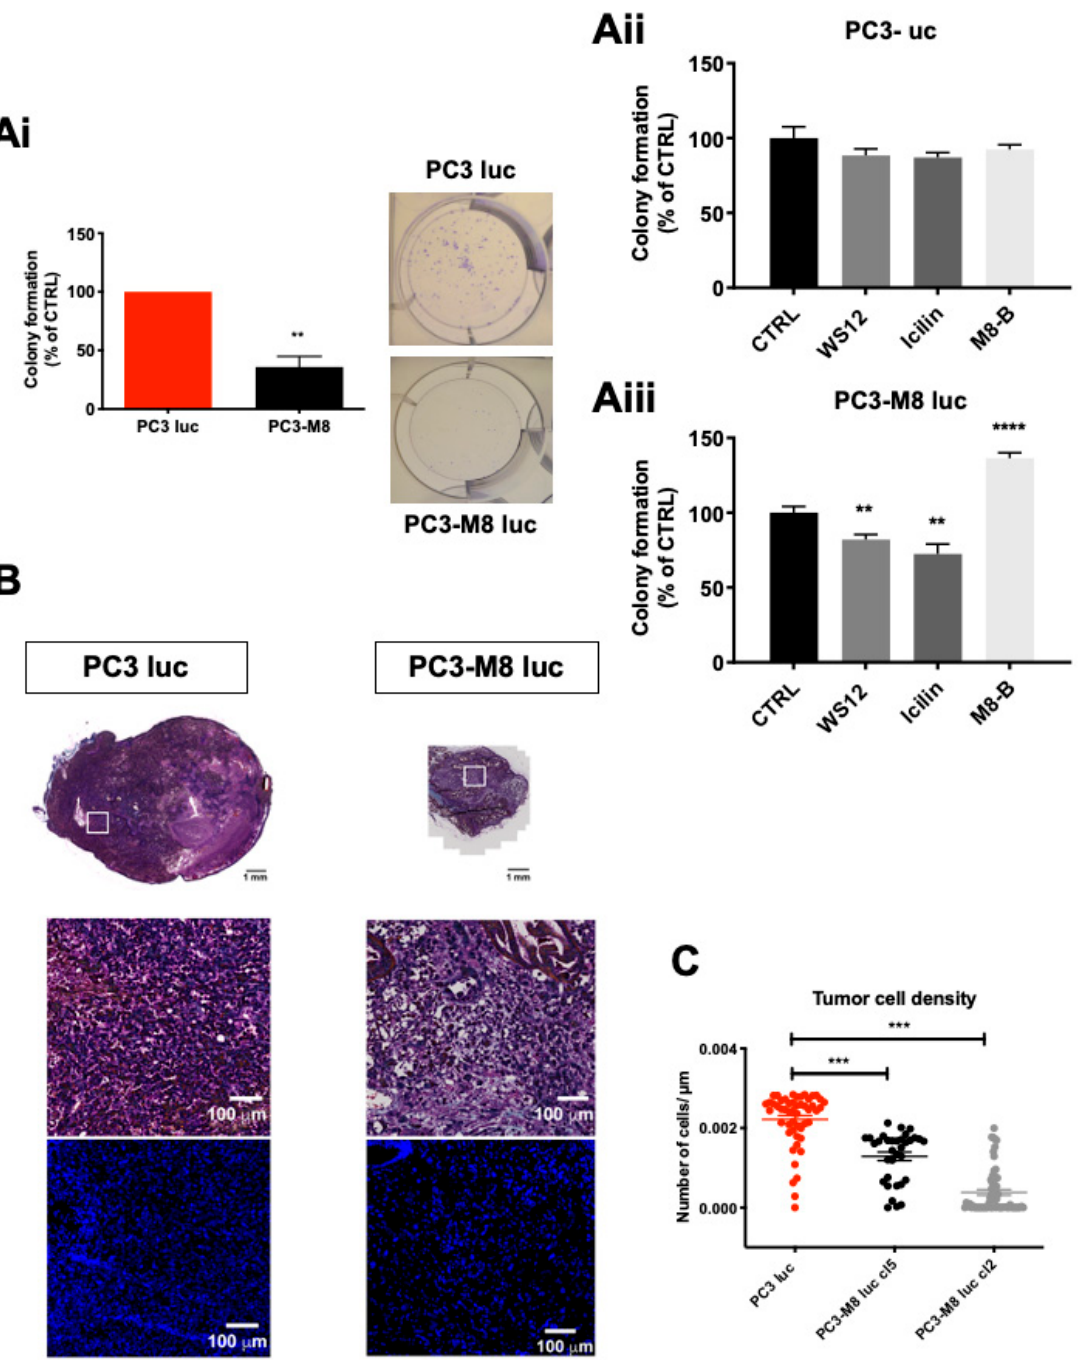
Figure 3. TRPM8 overexpression inhibits clone formation capability. ( A ) In vitro clonogenic assay of PC3 luc and PC3–M8 luc. Cells were seeded at 5 × 10 4 cells/well for two weeks and treated ( Aii , Aiii ) or not treated ( Ai ) with WS–12 (100 nM), icilin (10 µ M), or M8–B (1 µ M). The number of clones was quantified and normalized in the control condition (n = 6 independent experiments; statistical significance: ** = p < 0.01, **** = p < 0.001, unpaired Student’s t –test). ( B ) Images representing DAPI staining in tumors from PC3 luc and PC3–M8 luc grafts. ( C ) Quantification of cell density in tumors from PC3 luc (red dots); PC3–M8 luc cl5 (black dots) and PC3–M8 luc cl2 (grey dots) grafts. Tumor cell density is expressed as number of cell/ µ m 2 (n = 50 images/condition; statistical significance: *** = p < 0.001, ordinary one–way ANOVA with post hoc Tukey’s